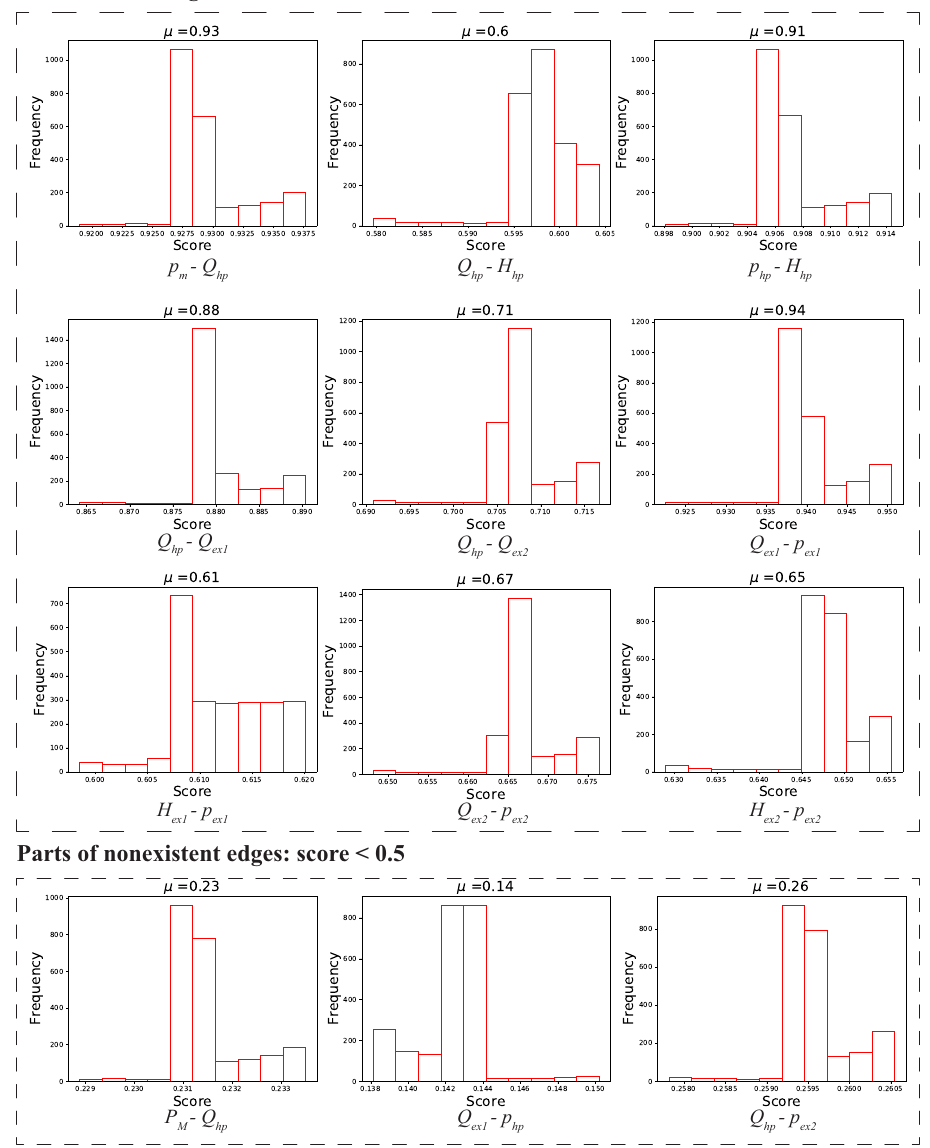
Figure 6. Histograms for the scores of existent and nonexistent